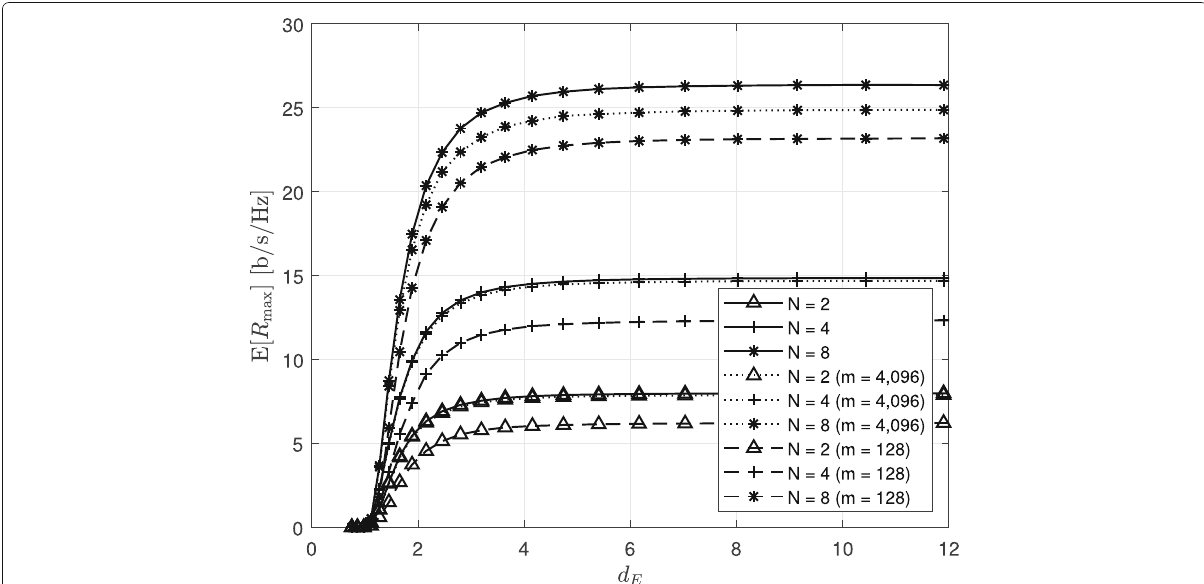
Fig. 10 Average maximum outage secrecy rate as a function of d E with Gaussian constellation, both infinite- and finite-length ( m = 128 and m = 4096) coding, and various values of N the two distances ( d I / d II ) and the distance among the relays vary, i.e., (cid:16) = { 0.05, 0.1, 0.5 } , for d E = 10, (cid:4) = 10 − 4 , and N = 4 relays.